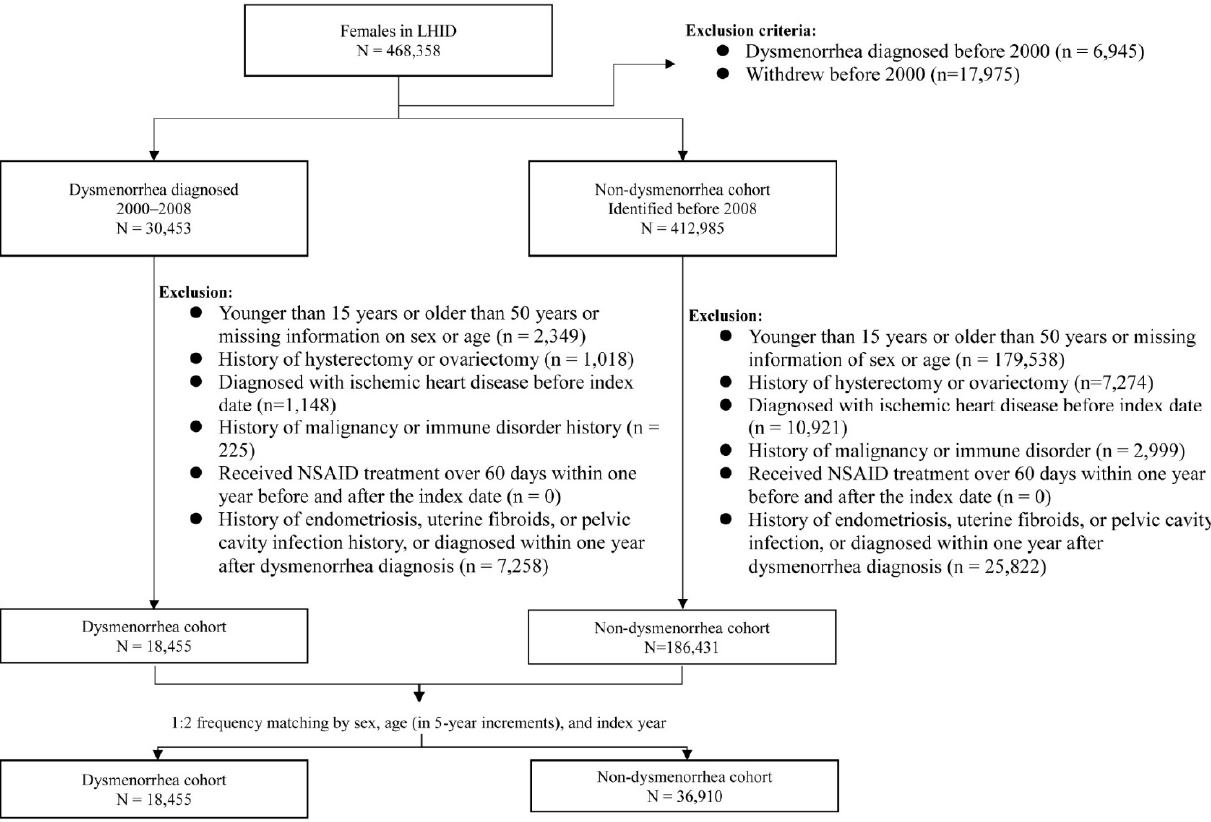
Figure 1. Flow chart for establishing study cohorts.